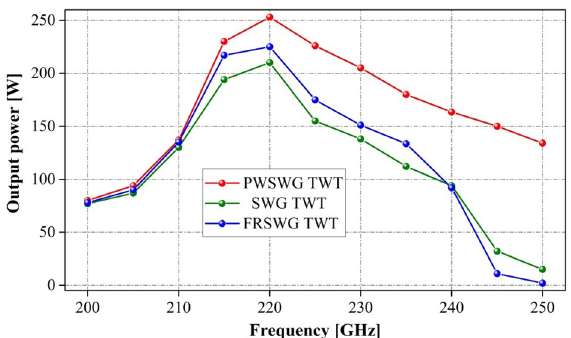
Figure 15. Comparison of output power of the PWSWG TWT, the SWG TWT and the FRSWG TWT.